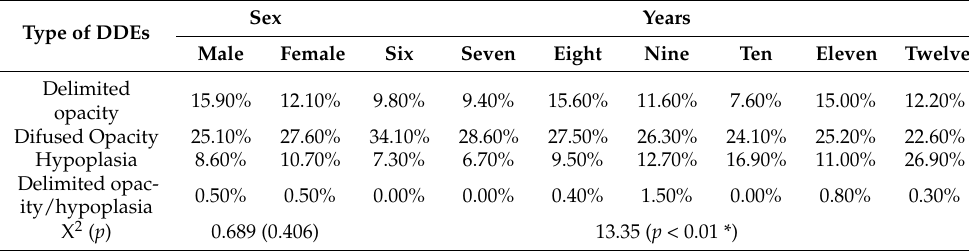
Without DDEs With DDEs n